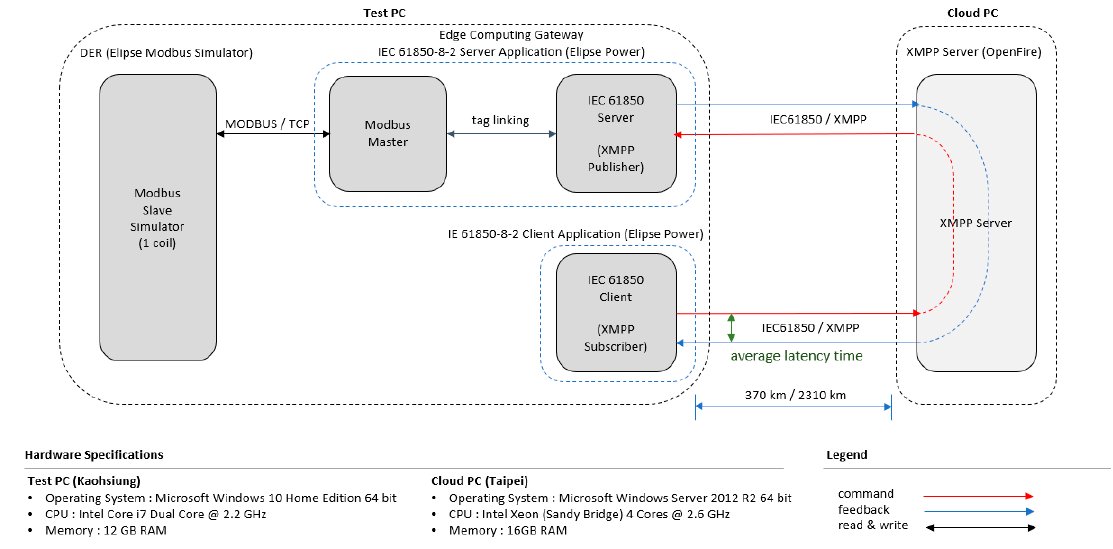
Figure 11. Test environment for latency command test.